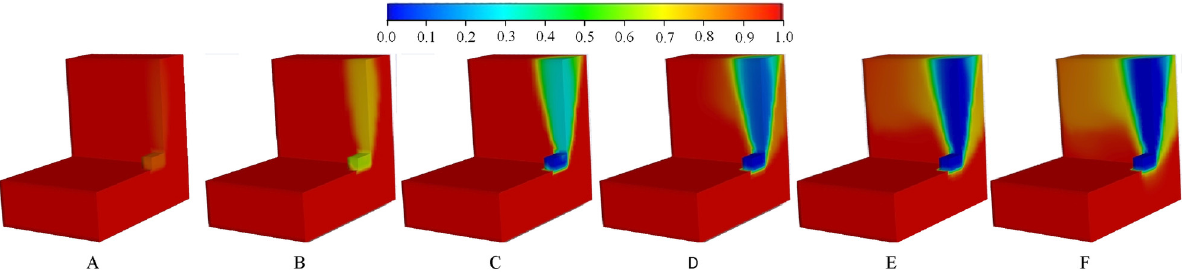
Figure 16. Progress of the material burnout (0 corresponds to the complete burnout) (description in text).